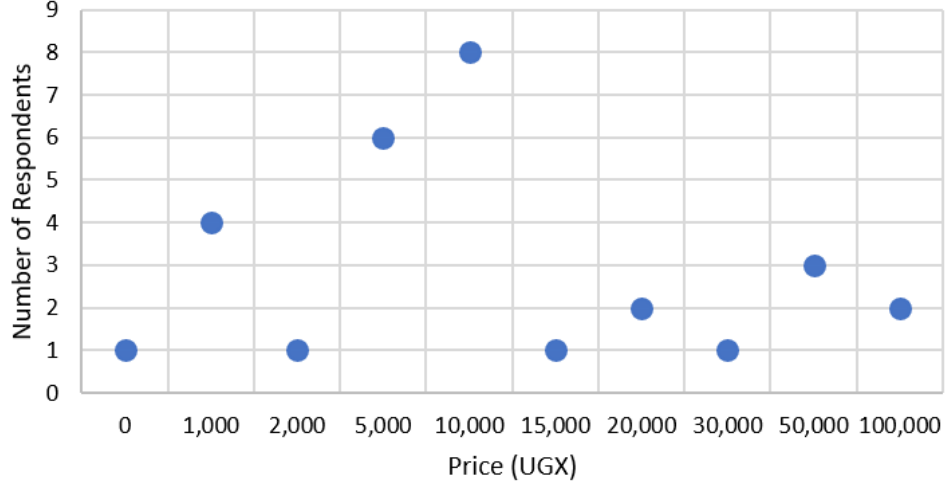
Figure 8. Distribution of mothers' willingness to pay for NeMo